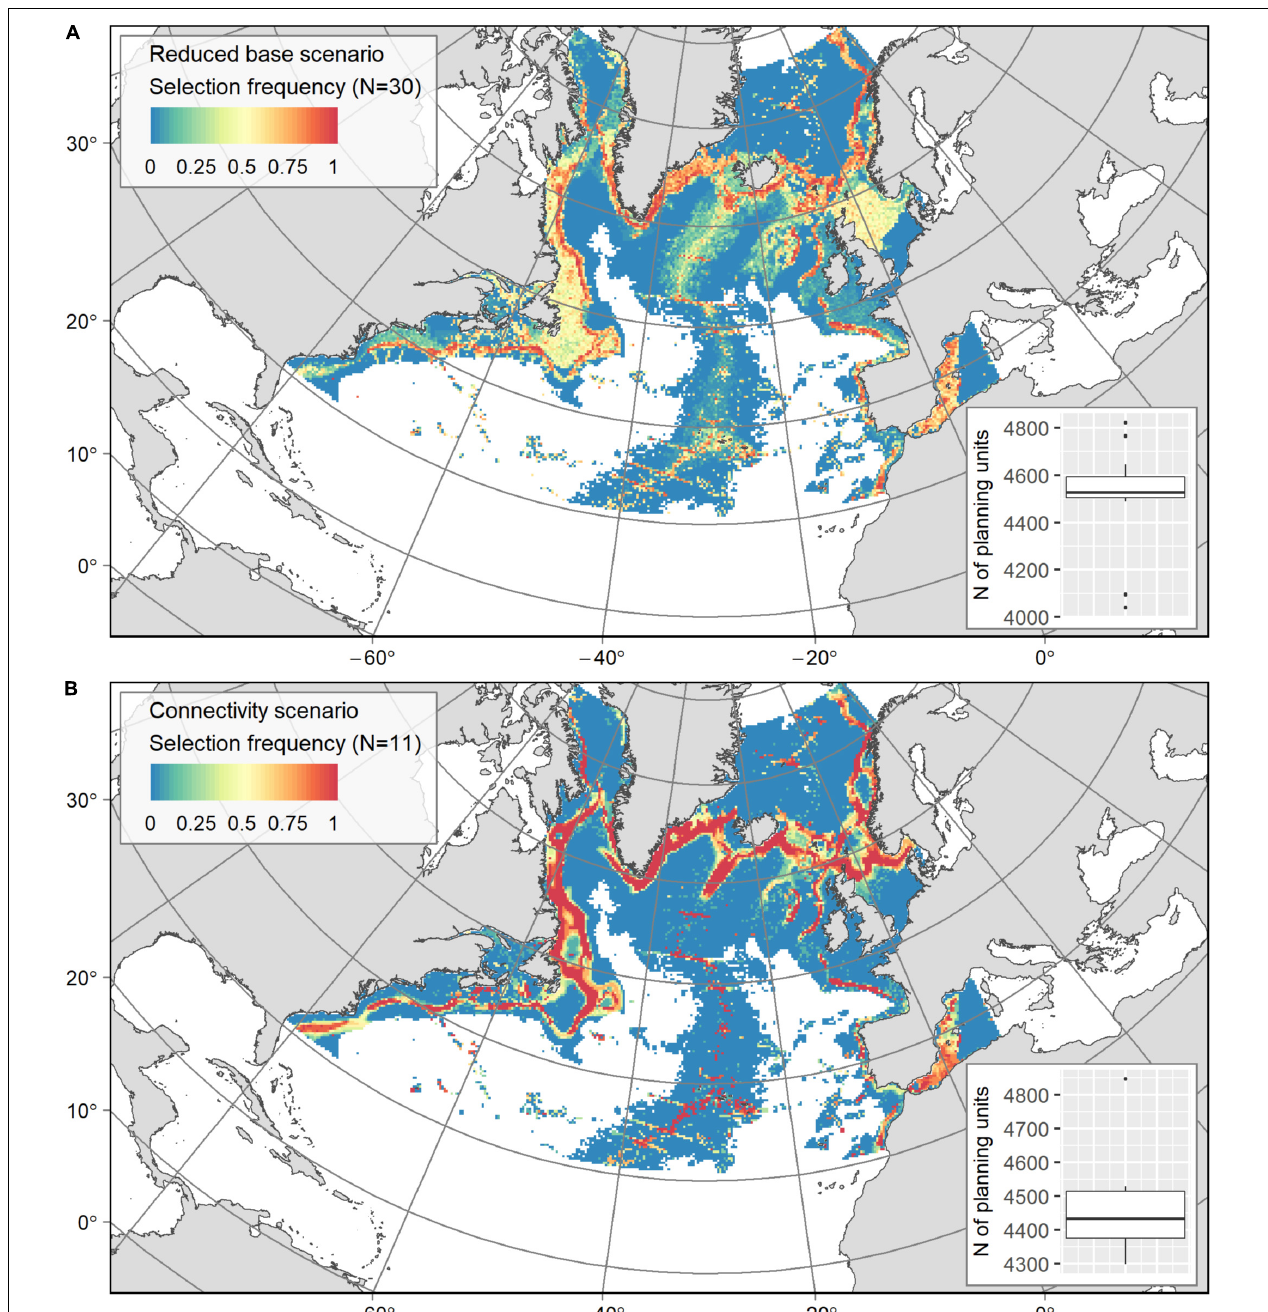
FIGURE 5 | Outputs from (A) the “Reduced Base” scenario and (B) the “Connectivity” scenario: maps of PU selection frequency from the N solutions with a boxplot showing the number of PUs in the solutions.